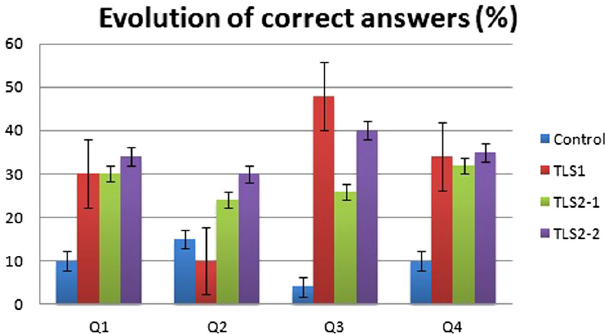
FIG. 6. The evolution of the prevalence of answers in category A (correct and underpinned by reasoning in accordance with the epistemology of science) for all the questions for control and experimental